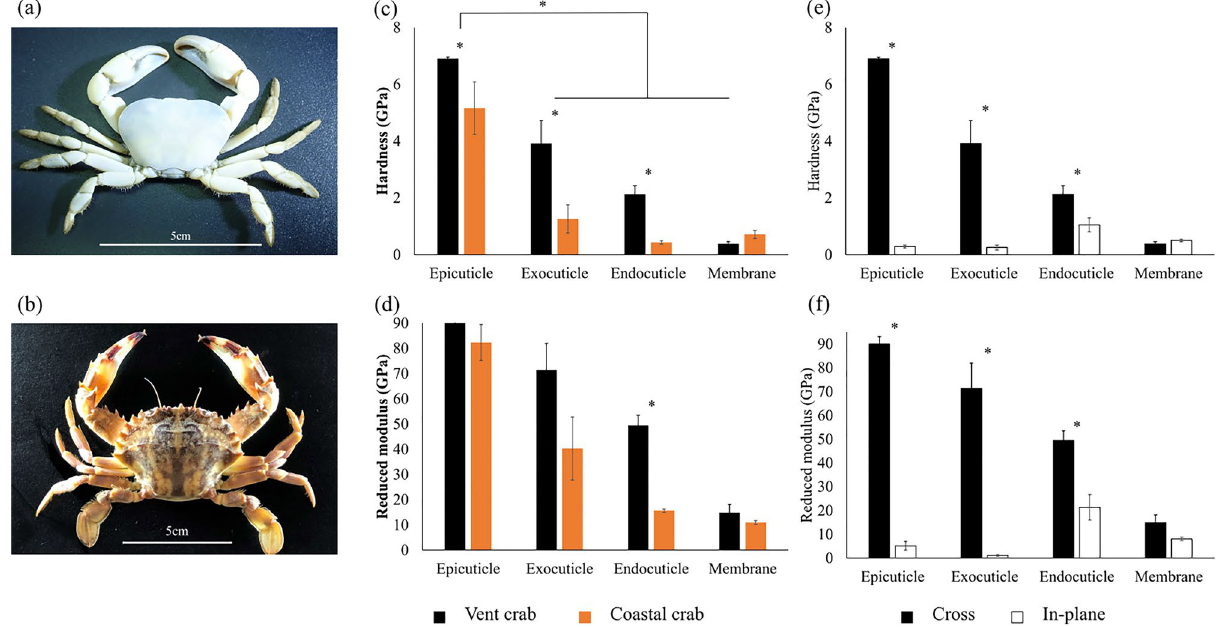
Figure 1. Crab samples and mechanical properties. The samples of the two species [( a ) Austinograea sp., ( b ) C. japonica ]. ( c , d ) The hardness and reduced modulus of the exoskeletons of the two crabs in cross-sections (mean ± SE). ( e , f ) The hardness and reduced modulus of the vent crab in cross-sections and in-plane sections 14 (mean ± SE) [significant difference is indicated by an asterisk (*)].